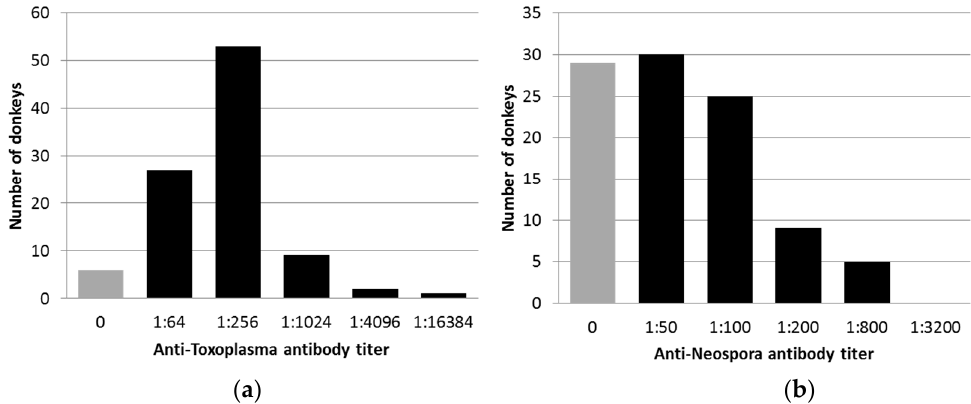
Figure 1. The distribution of anti- T. gondii ( a ) and anti- Neospora spp. ( b ) antibody titers in 98 donkeys, as detected by immunofluorescence antibody tests (IFATs).